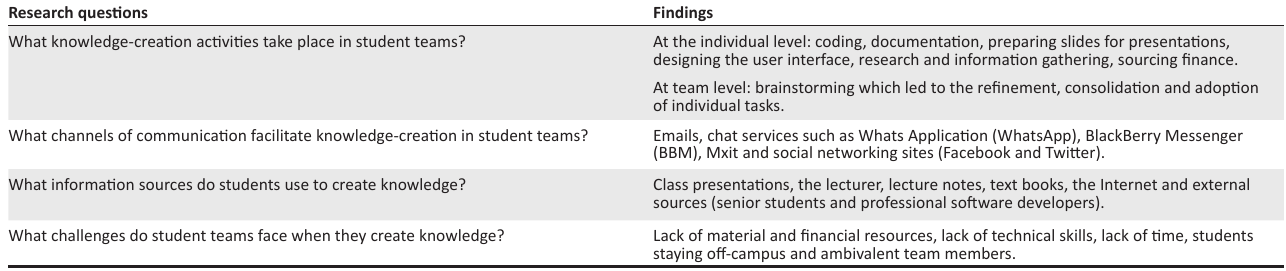
TABLE 1: A summary of research